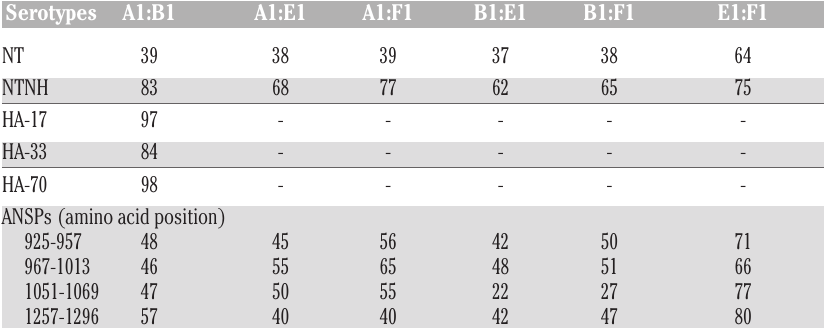
Table 3. Comparison of percentage amino acid identity of neurotoxin gene cluster, and antibody neutralization specific polypeptides (ANSPs) of neurotoxin in serotypes A, B, E, and F of C. botulinum